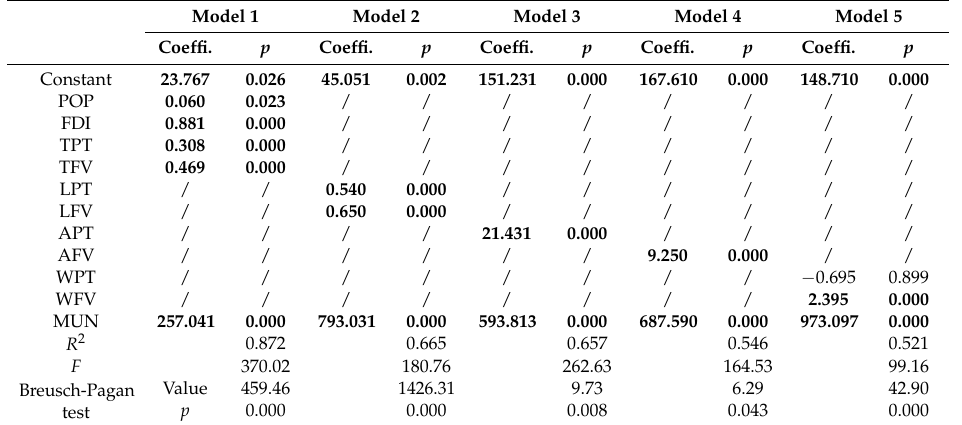
Table 4. Non-spatial estimation